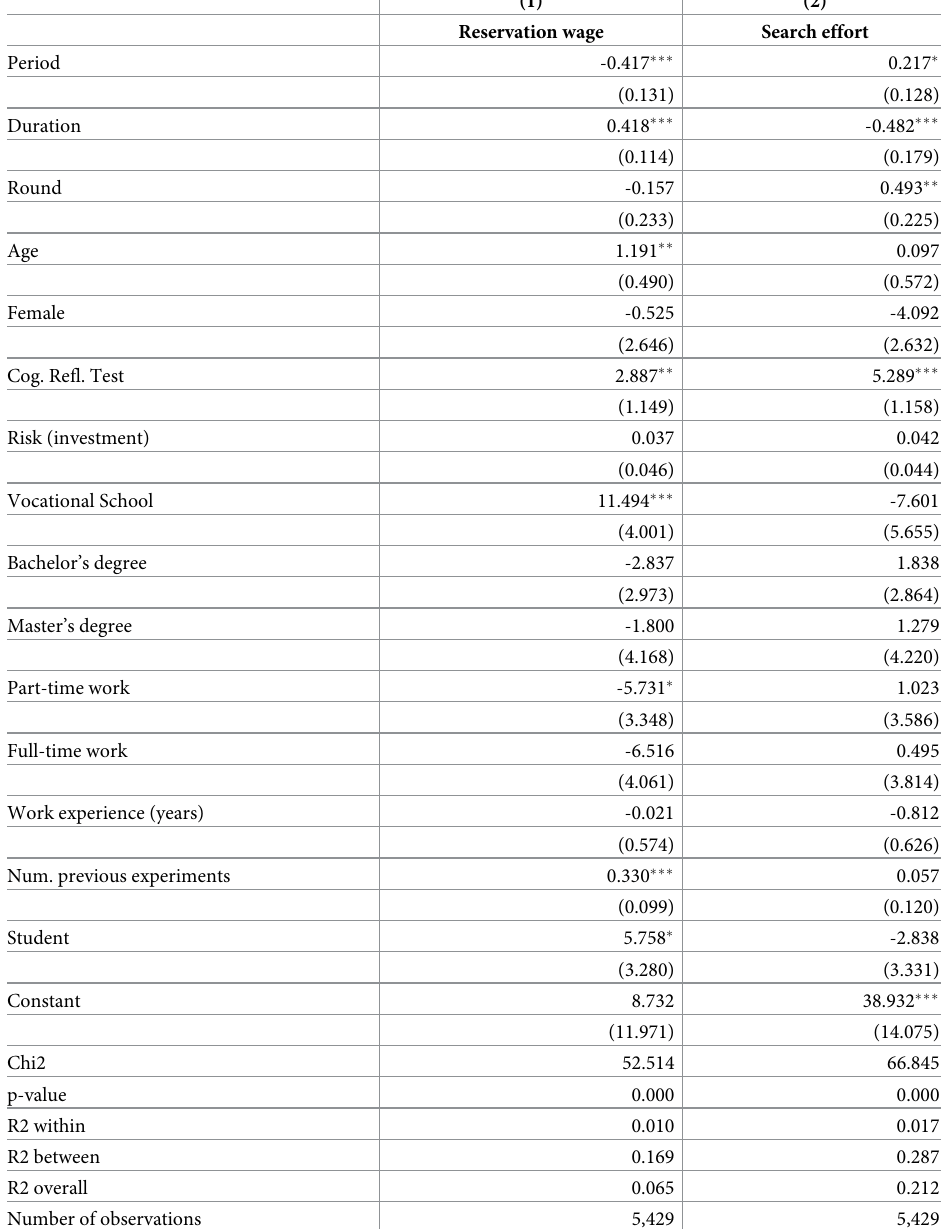
Table 2. Changes in search behavior over the search spell in Baseline